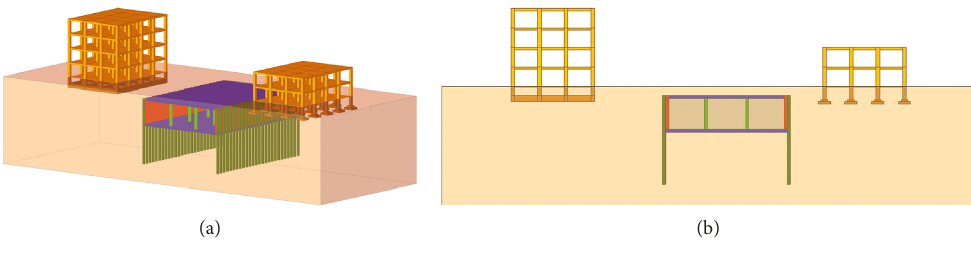
Figure 11: The renderings of the scale test model. Table 2: The steps of dial indicators data